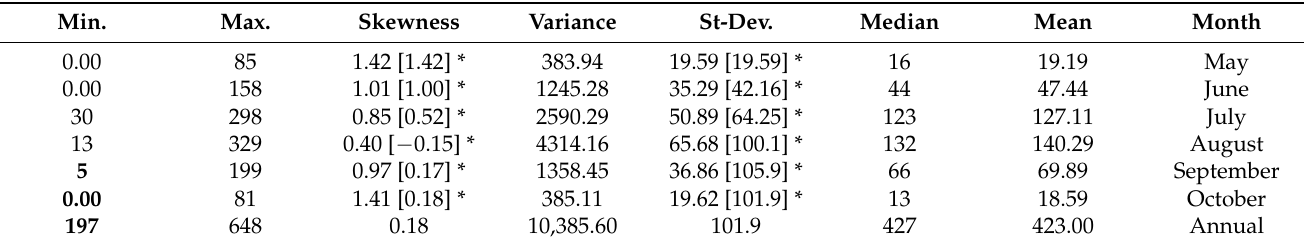
Table 2. Seasonal (monthly and annual) hydrological